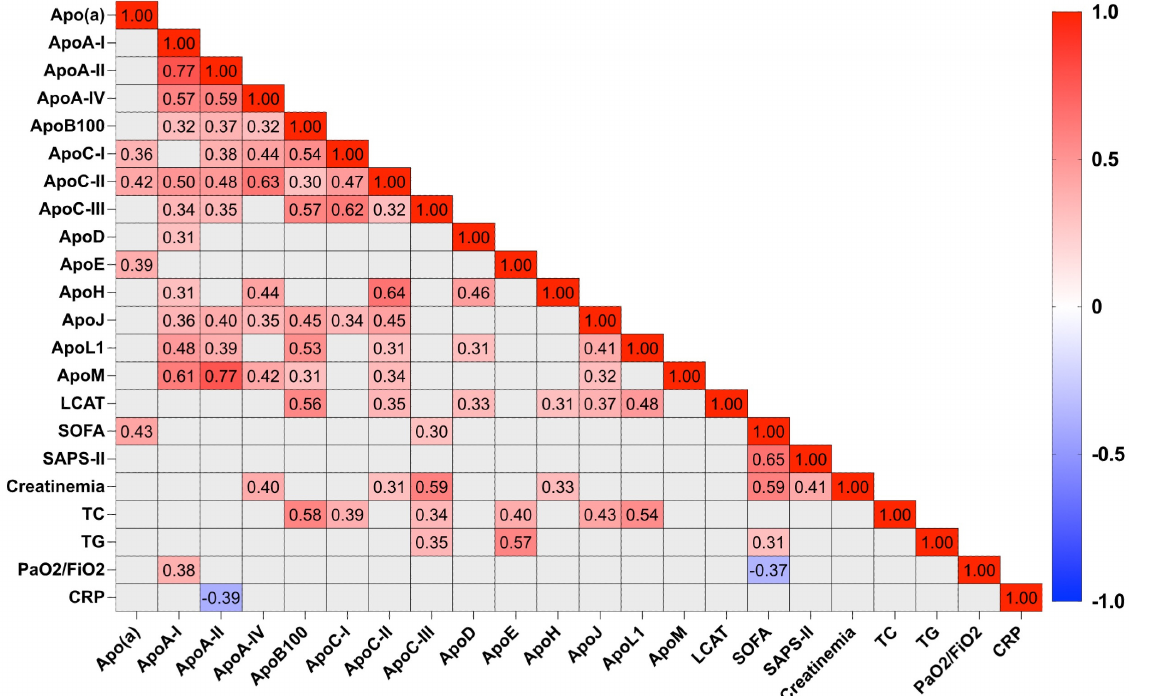
Figure 3. Heat map representing correlations between apolipoproteins and selected biological and severity score markers. A Pearson correlation was performed. The positive correlations that are statistically significant are in red, the negative correlations are in blue and non-significant correlations are in grey.